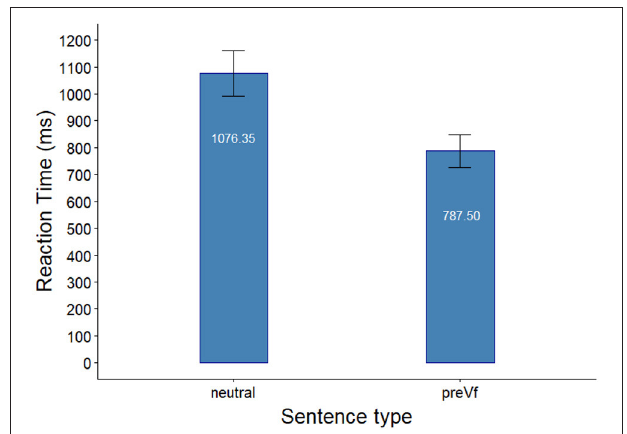
FIGURE 1 | RTs in the Same-conditions in Experiment 1. Error bars indicate the standard error of the mean.